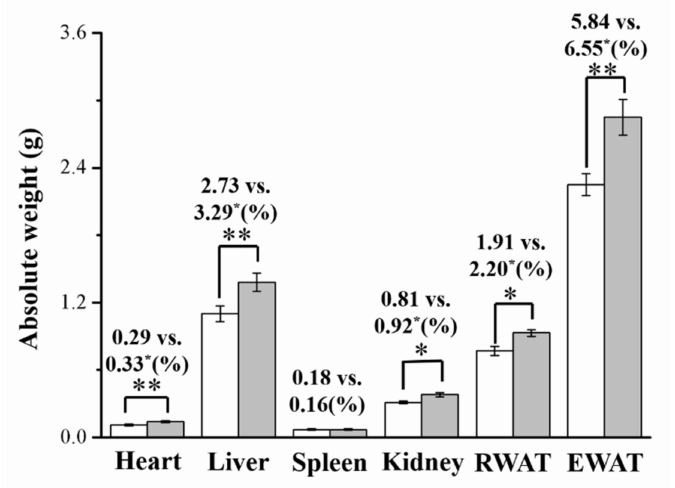
Figure 2. Effects of imipramine on total heart, retroperitoneal white adipose tissue (RWAT), spleen, liver, kidney, and epididymal white adipose tissue (EWAT) weights (shown as a percentage of total body weight). Both groups’ data are in the form of mean ± standard deviation ( n = 8). * p < 0.05; ** p <